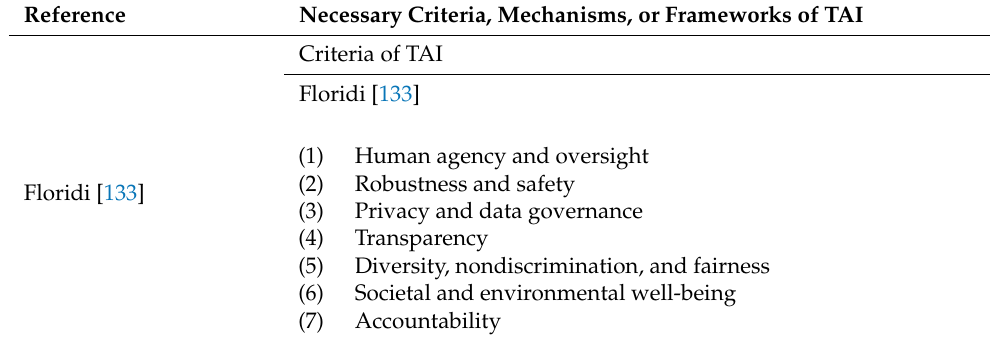
Table 8. Summaries of the necessary criteria, principles, and mechanisms of